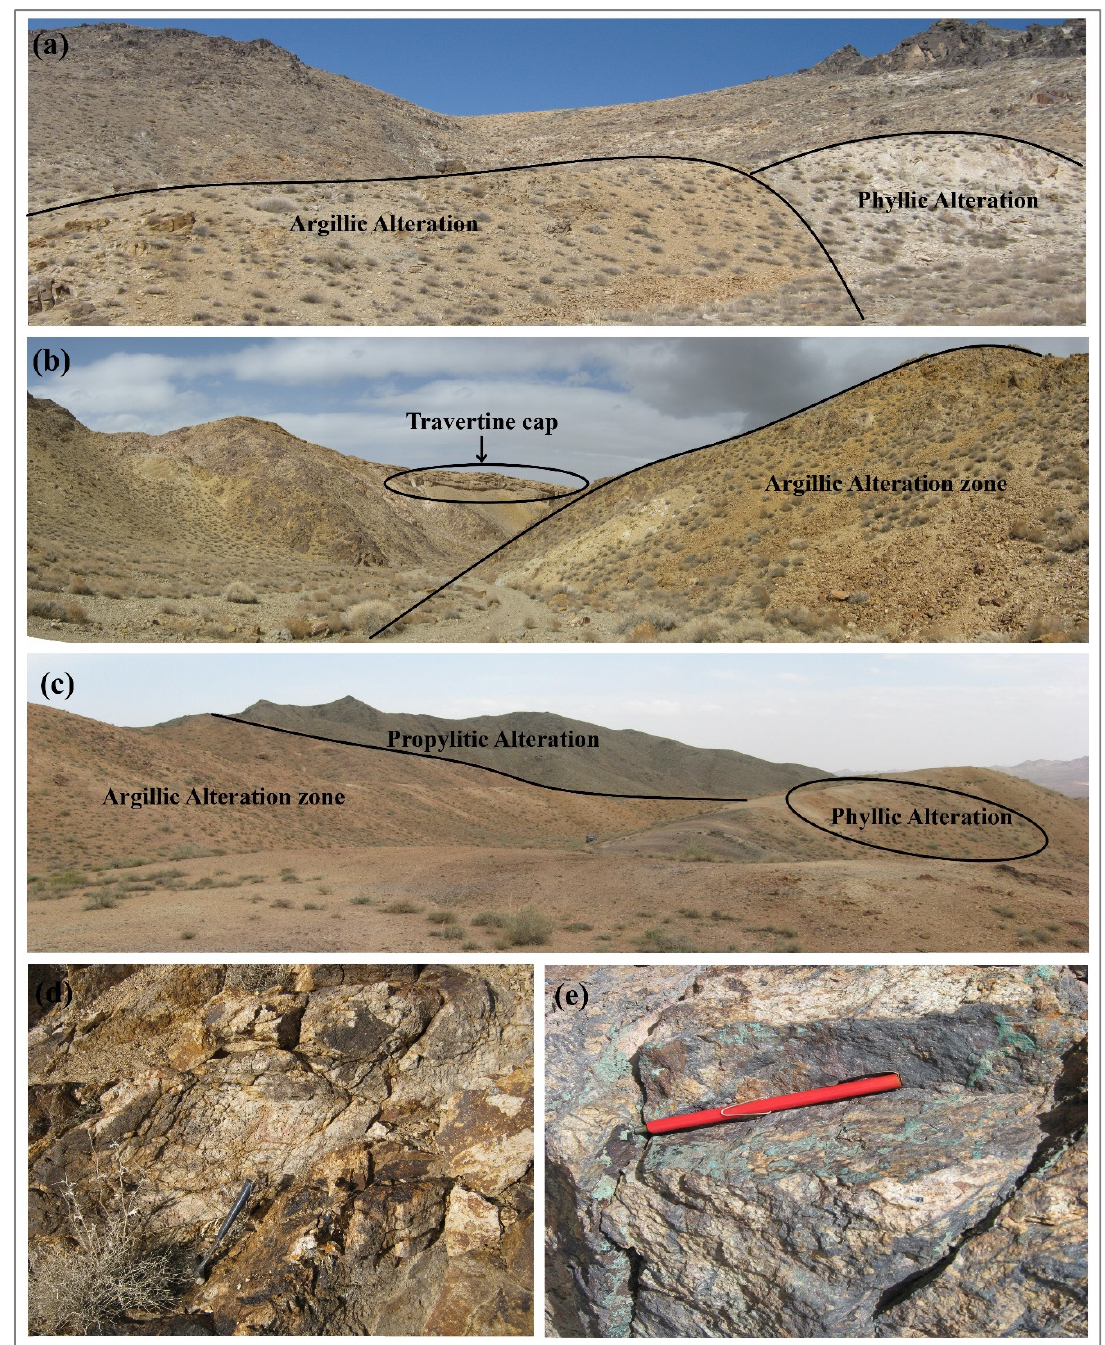
Figure 11 . ( a ) Argillic and phyllic alterations in the area of the S04 and S05 sampling points; ( b ) argillic alteration in the area where the S12, S13 and S14 samples were taken; ( c ) propylitic, argillic and phyllic alteration in the S15, S16, S17, S18 and S19 sampling zones; ( d ) argillic alteration; ( e ) malachite mineralization observed in the southeastern part of the study area.